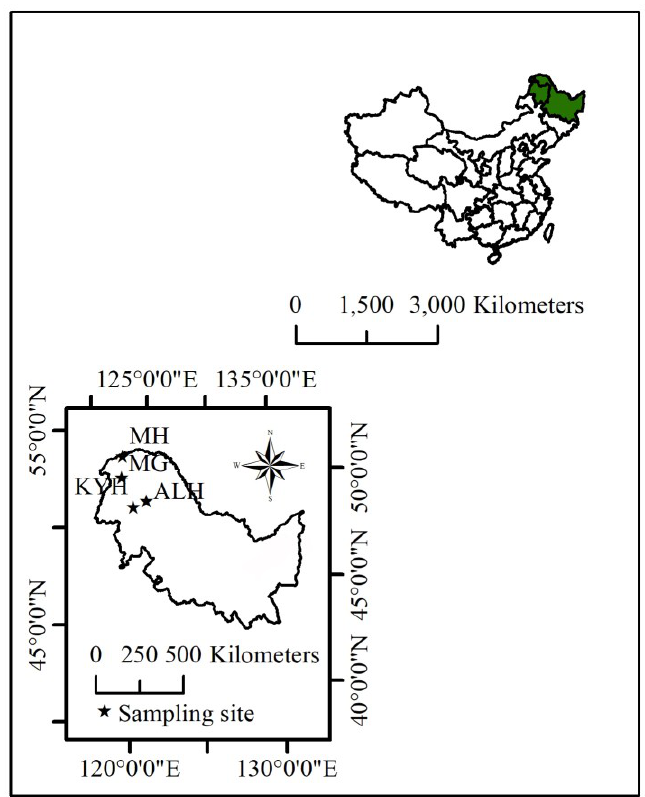
Figure 1. Locations of the sampling sites in Northeast China. Abbreviations for our sampling sites are MH (Mohe), MG (Mangui), ALH (Alihe) and KYH (Keyihe).